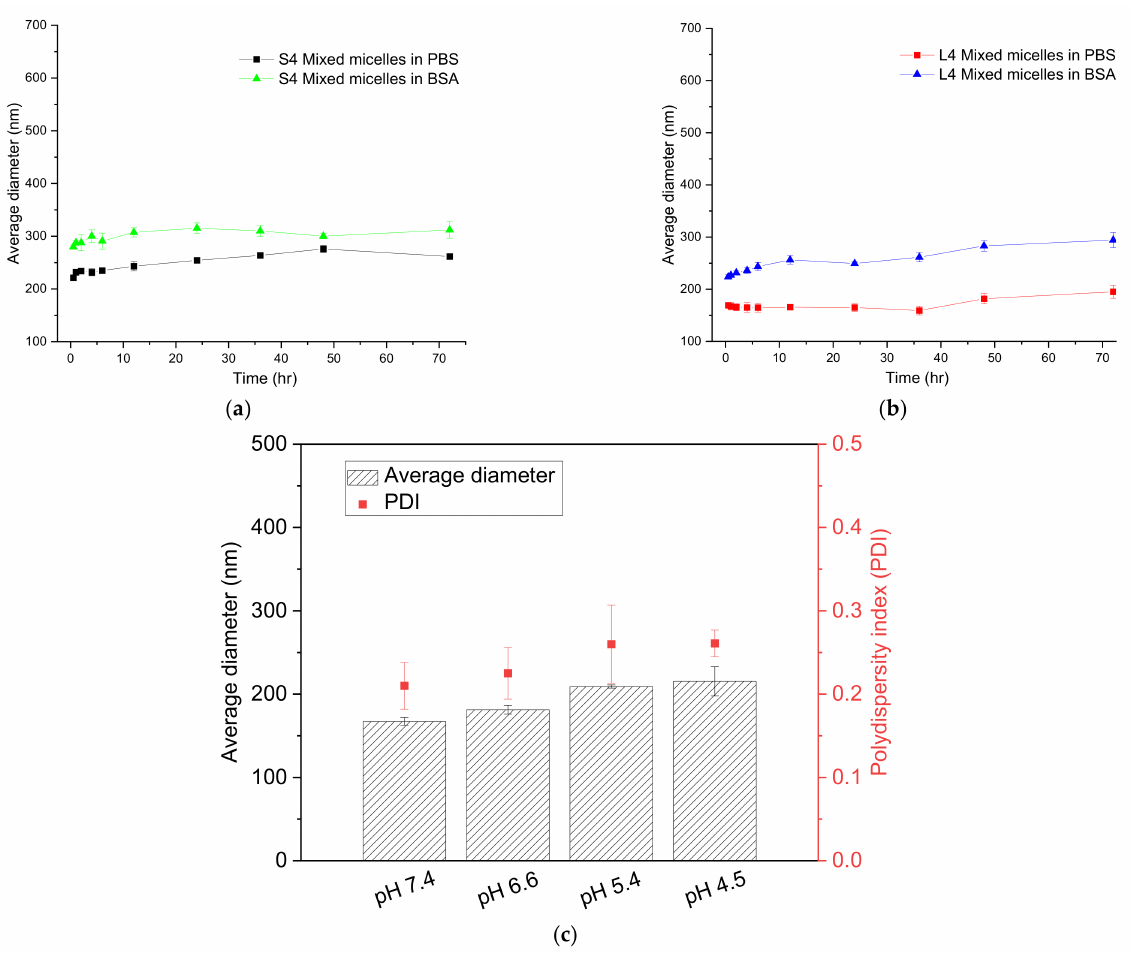
Figure 2. Stability and pH-responsive tests of the mixed micelles. The particle sizes of ( a ) S4 and ( b ) L4 polymeric mixed micelles in pH 7.4 and 4% BSA environments. ( c ) The particle sizes and PDI of the L4 mixed micelles in different pH (pH 7.4, 6.6, 5.4, and 4.5) conditions. The particle sizes and PDI values were determined by dynamic light scattering (DLS). All results are presented as mean ± SD ( n =